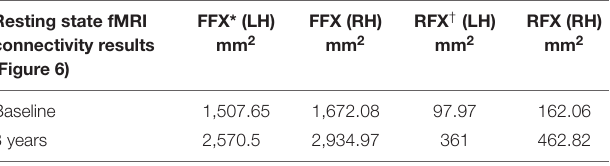
TABLE 4 | Quantification of the resting state functional connectivity of the primary auditory (BA41) and visual areas (presented in Figure 6 ), at baseline and 3 years post–retinal gene therapy.